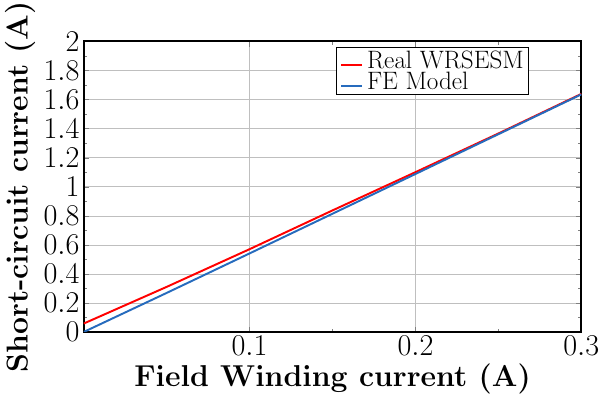
Figure 9. Open-circuit characteristics of the FE model and real WRSESM.